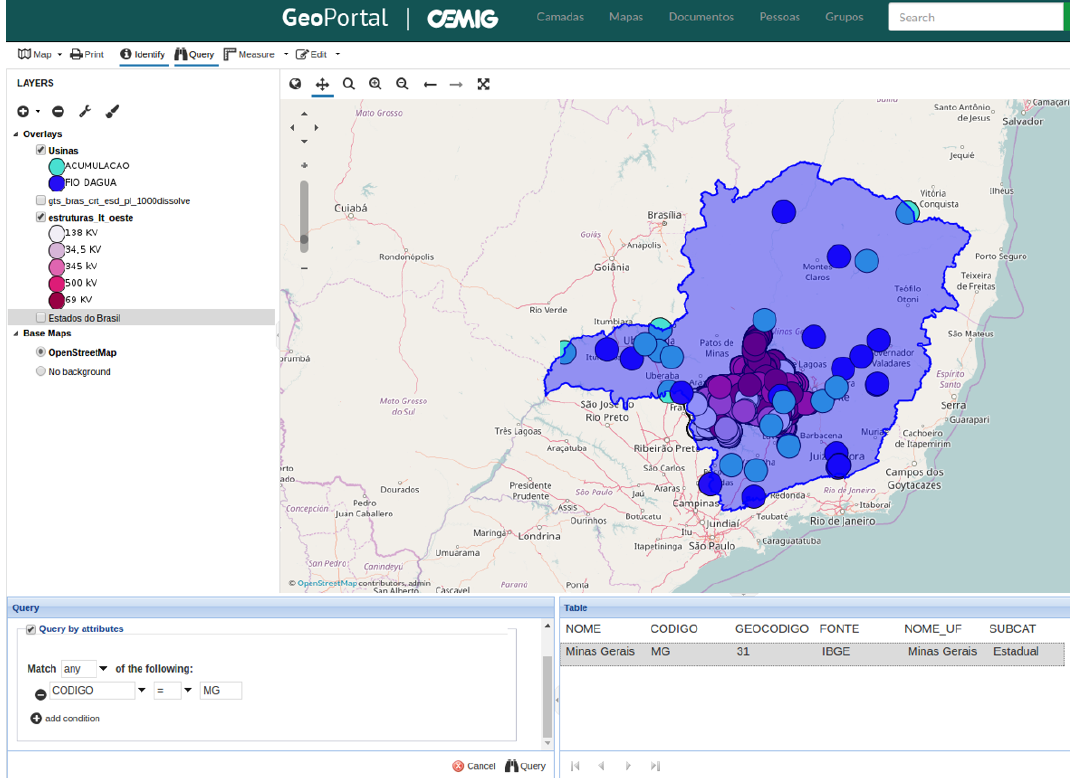
Figure 13. Example screen of the layer viewer of the geoportal